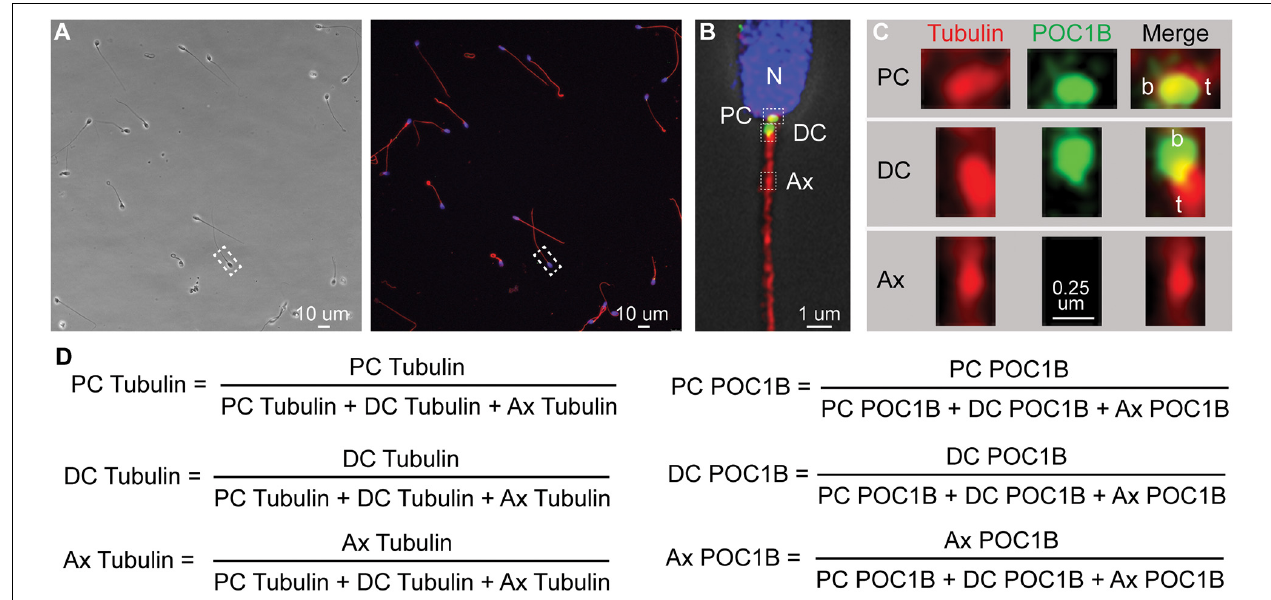
FIGURE 1 | Quantitative imaging of sperm centriole markers. (A) An example phase and fluorescent image of a group of pellet spermatozoa. Such a picture ordinarily contains 10–30 spermatozoa. (B) Zoom in on one sperm from (A) that was deconvolved using HyVolution. Nucleus (N). Three boxes point the approximate location of the PC, DC, and Ax, insets presented in panel (C) . (C) Zoom in on the Proximal centriole (PC), distal centriole (DC), and axoneme (Ax) of sperm from panel (B) labeled with Anti-POC1B and anti-tubulin antibodies. Centriole base (aka proximal end), b; the centriole tip (t) (aka distal end). We consistently find that POC1B labeled more intensely at the proximal end of the tubulin staining. In the PC, this relative position may be because of the presence of microtubular tip extension, known as the centriolar adjunct. In the DC, this relative position may be due to the higher concentration of microtubules at the DC tip. Tubulin staining in the PC and DC is more intense then the nearby axoneme possibly because the PC and DC microtubules were unmasked during centrosome remodeling (Fishman et al., 2018). Because the centrioles are intensely stained with tubulin antibodies, we diluted tubulin antibodies and avoid their exposer to intense laser power that saturates the tubulin labeling. As a result, the axoneme labeling appears punctate. (D) The six mean ratios by marker and location. The picture is oriented with the PC on the right as describe in Khanal et al. (2021).